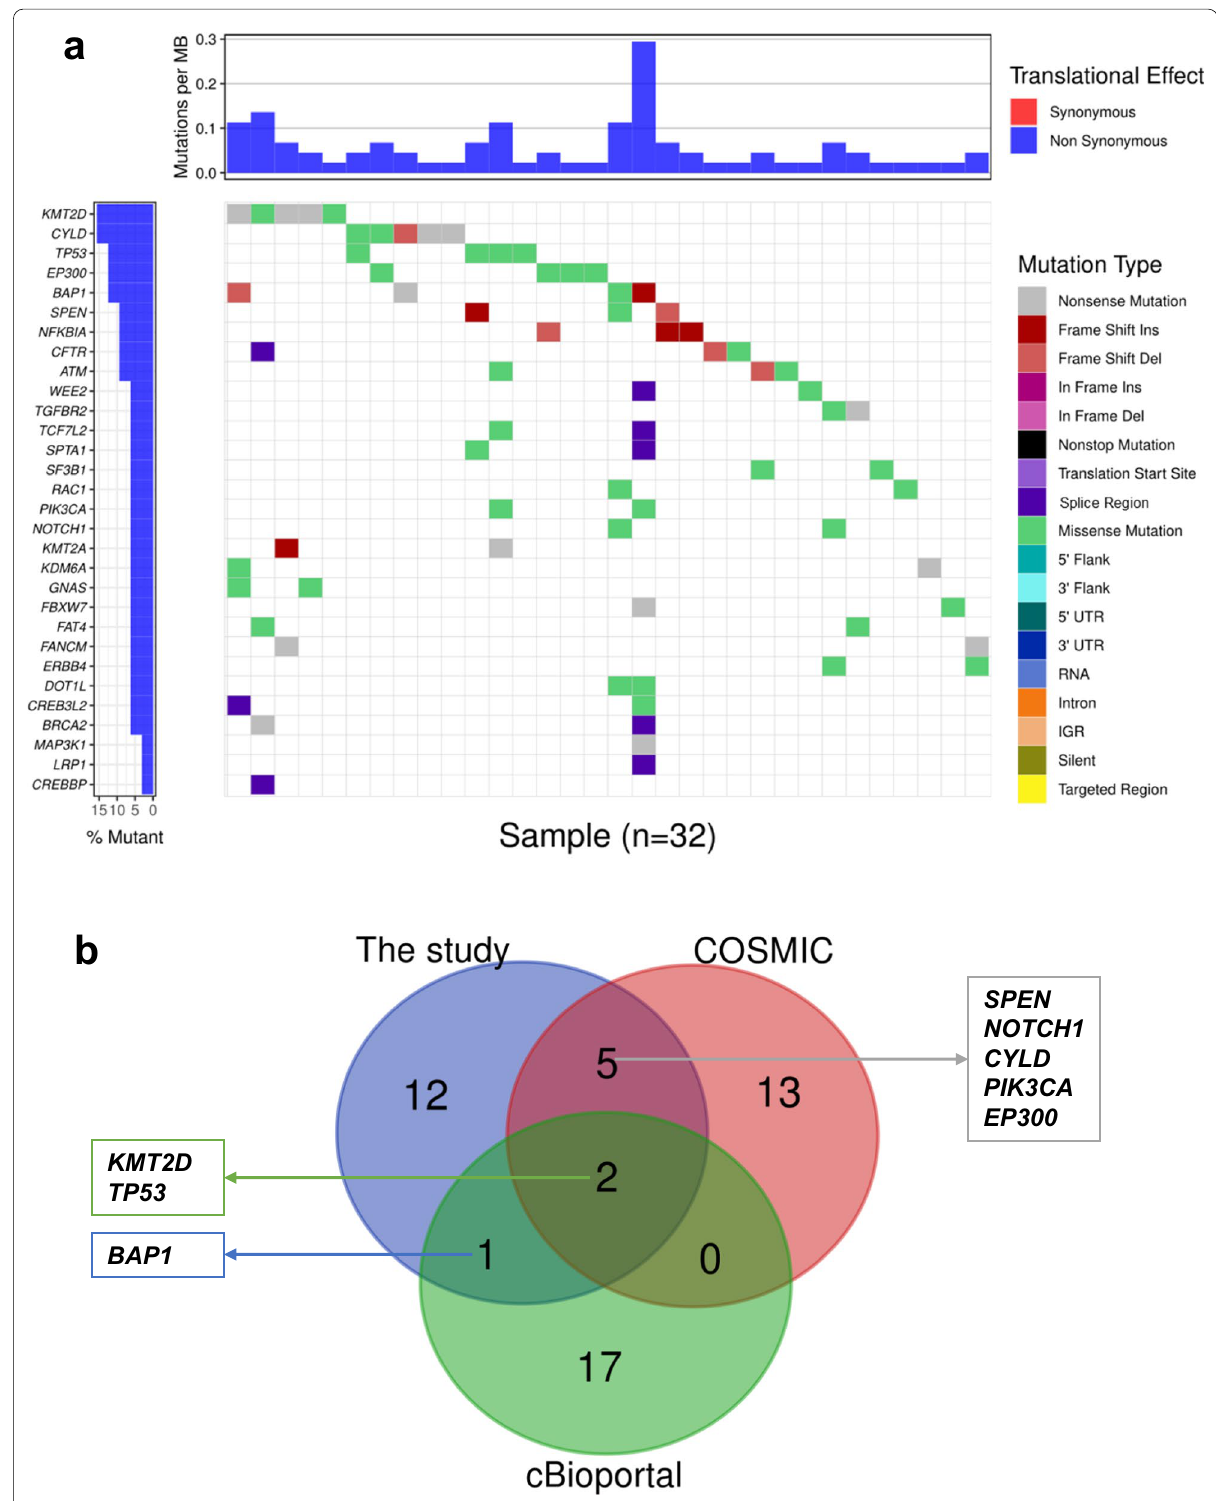
Fig. 1 Significantly mutated genes of nasopharyngeal carcinoma (NPC). a Waterfall plot of the mutations among NPC patients. b The twenty most frequently mutated genes were compared to the COSMIC database and cBioPortal